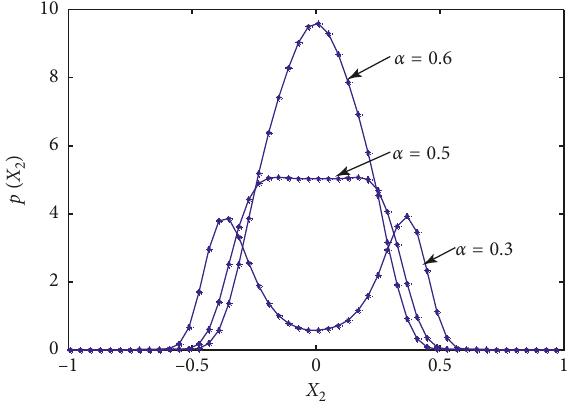
Figure 8: Section graphs of probability density functions when x